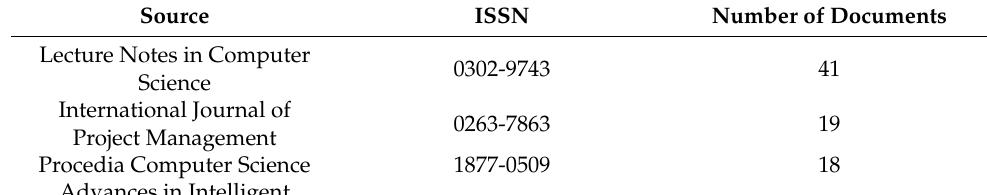
Table 2. Main sources of published documents.